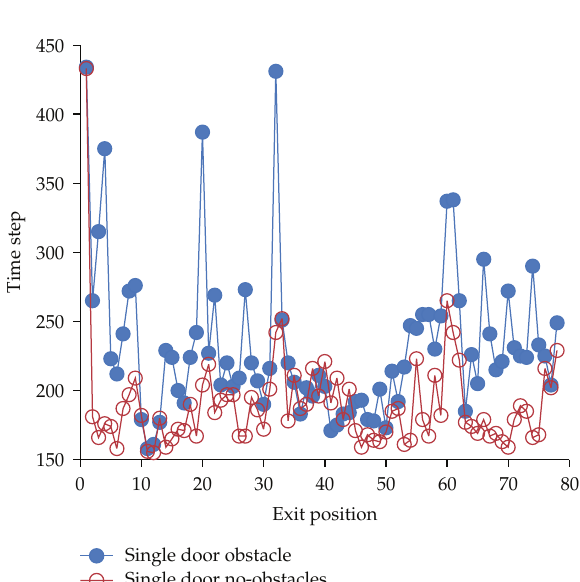
Figure 14: Types of exit doors.